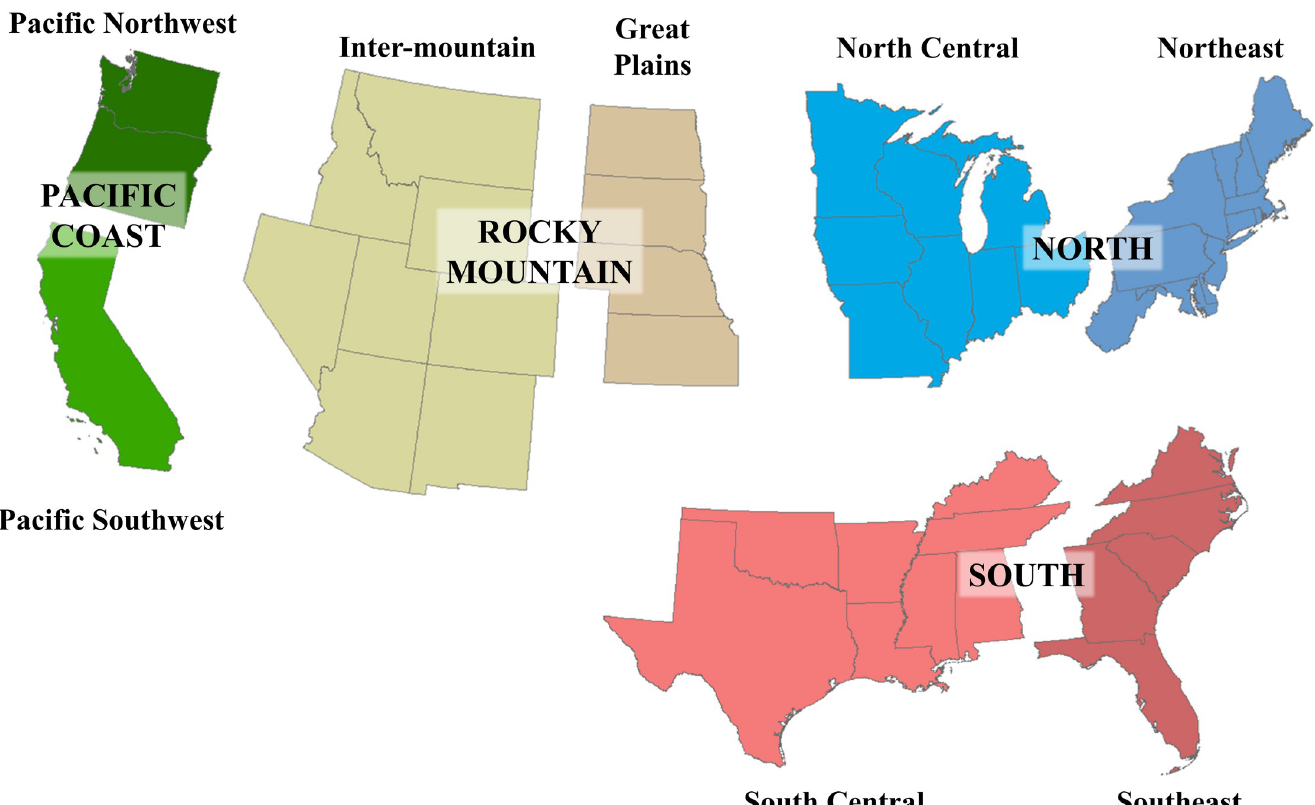
Fig 2. Study area. The conterminous United States (CONUS), as divided into the eight regions used by the Resource Planning Act (RPA) assessments. State boundaries are based on data freely available through the US Census Bureau (https://www.census.gov/geographies/mapping-files/time-series/geo/tiger-line-file.html).